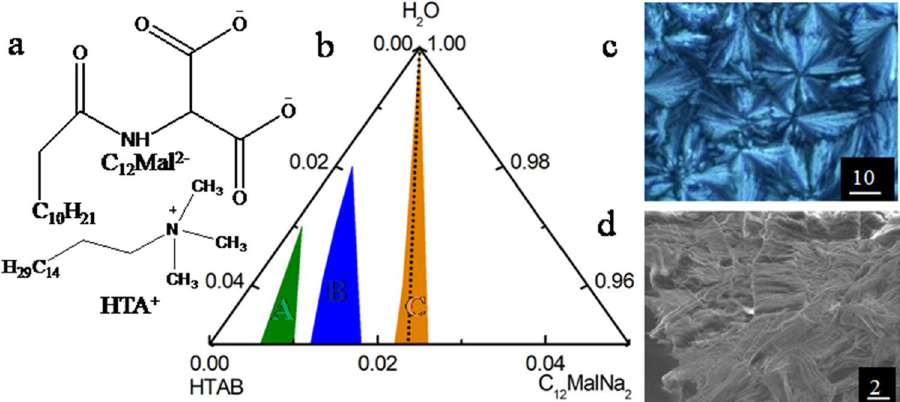
Figure 1. ( a ) Chemical structure of C 12 Mal 2– and HTA + ; ( b ) truncated phase diagram of C 12 MalNa 2 + HTAB + water mixed system at 25 °C. Phases: (A), gel; (B), viscous; (C), precipitate; and clear region indicate the formation of micelle. The dotted line in panel b corresponds to equimolar region. Panel ( c ), POM and ( d ), FE-SEM image of 5 wt% C 12 MalNa 2 + HTAB (40:60, w / w ) gel respectively. Scale bars (in μm) are mentioned in the microscopic